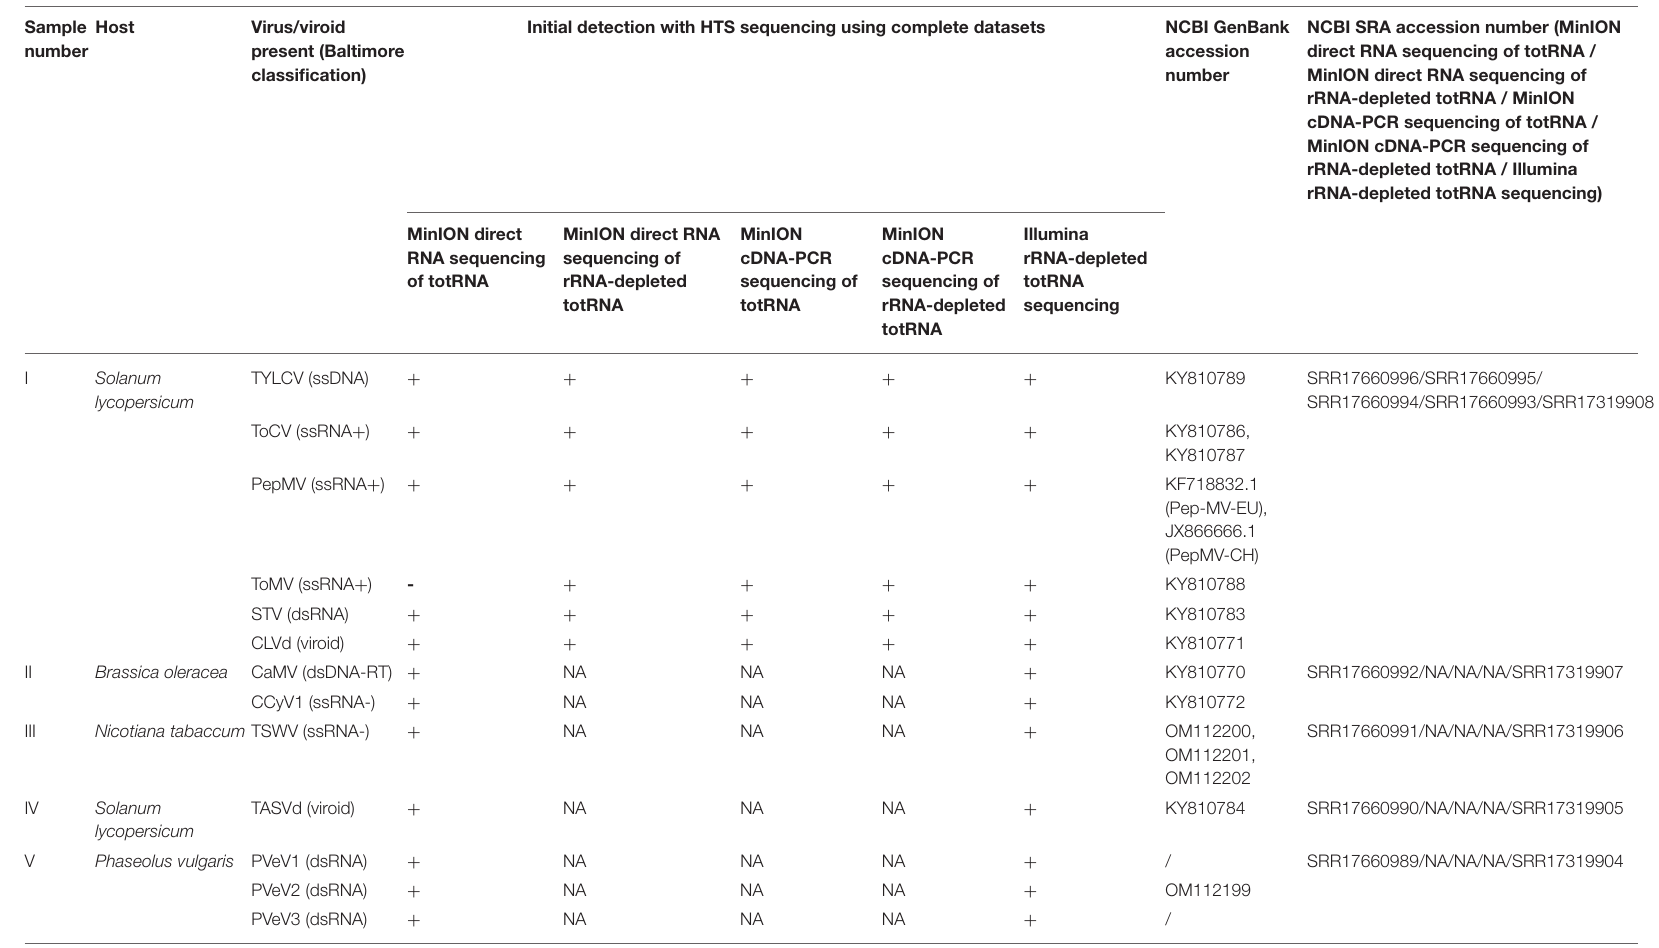
TABLE 1 | Samples included in the comparison with corresponding results from: HTS ( + virus/viroid detected using pipeline described in section Virus and Viroid Detection Workflow,–virus/viroid not detected using pipeline described in section Virus and Viroid Detection Workflow; NA, not